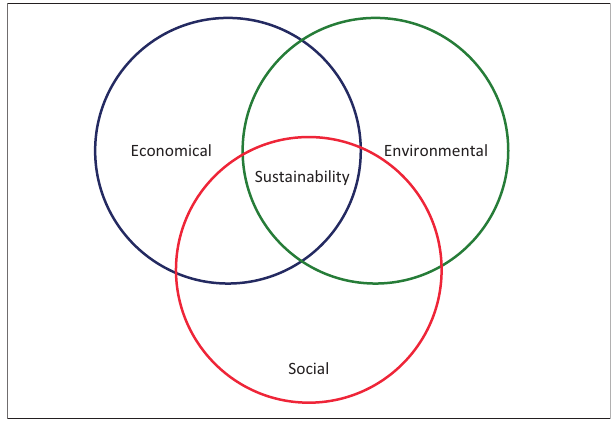
FIGURE 1: The triple bottom line and